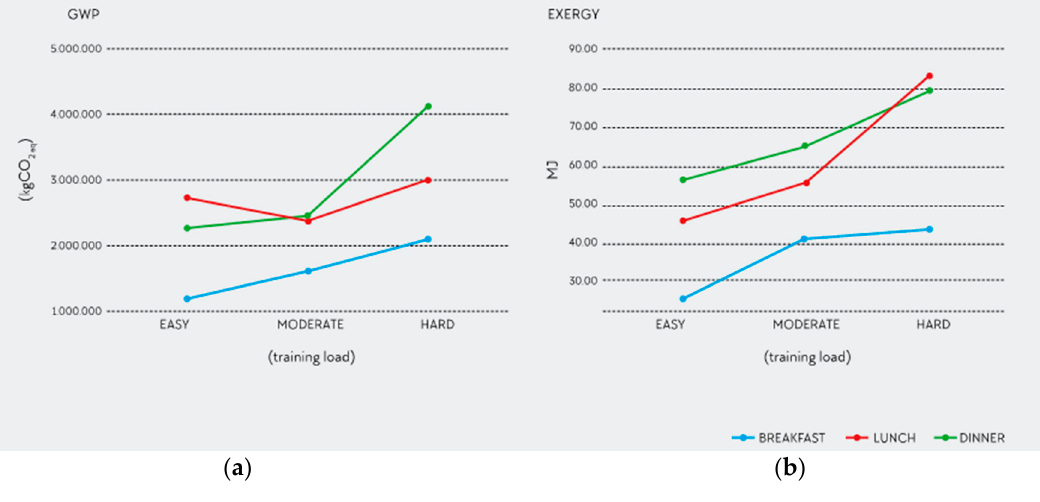
Figure 7. Boxplots by training load and meals for all four environmental categories. EB: Easy breakfast; EL: easy lunch; ED: easy dinner; Etot: easy daily totals; MB: moderate breakfast; ML: moderate lunch; MD: moderate dinner; Mtot: moderate daily totals; HB: hard breakfast; HL: hard lunch; HD: hard dinner; Htot: hard daily totals. Table 3. Standard deviation of the environmental impacts of the 12 dietitians (easy, moderate and hard plates) for daily totals (sum of breakfast, lunch and dinner). DIETITIAN